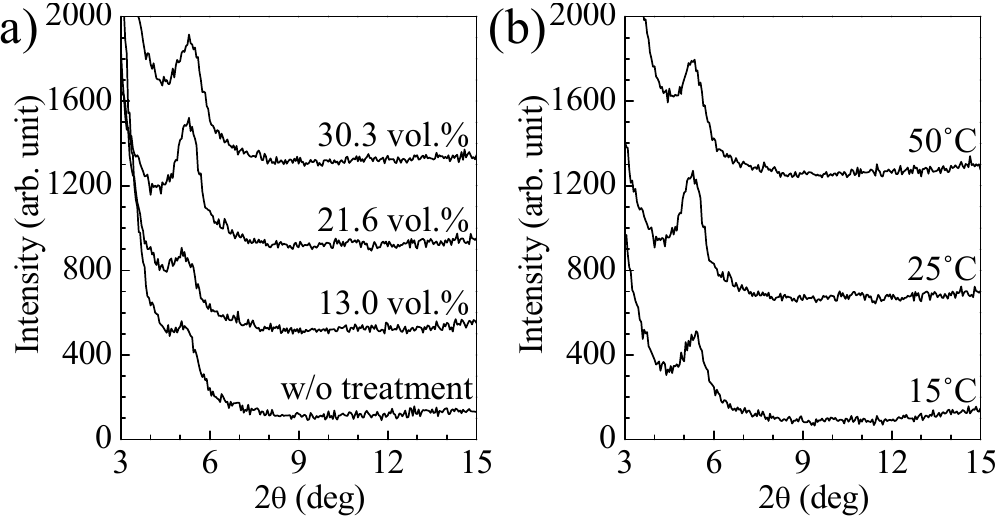
Figure 2. XRD patterns of the spin-coated PAT6 films depending on ( a ) vapor concentrations at constant temperature of 25 °C, and ( b ) temperature at at contant 21.6 vol % vapor concentration in